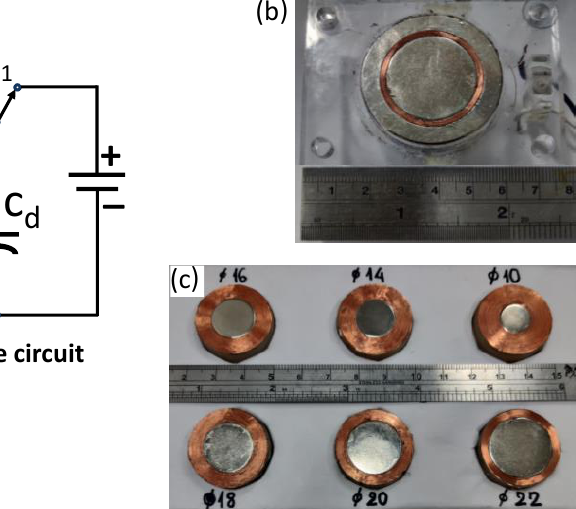
Figure 2. The prototype EMAT for coin identification: ( a ) working principle, the blue and red colors indicate the south and north magnetic poles; ( b ) the photograph of the magnet-and-coil assembly with a 25-mm inner magnet; ( c ) the photograph of the spiral-coil-and-inner-magnet sets with the diameter ranging from 10 mm to 22 mm.